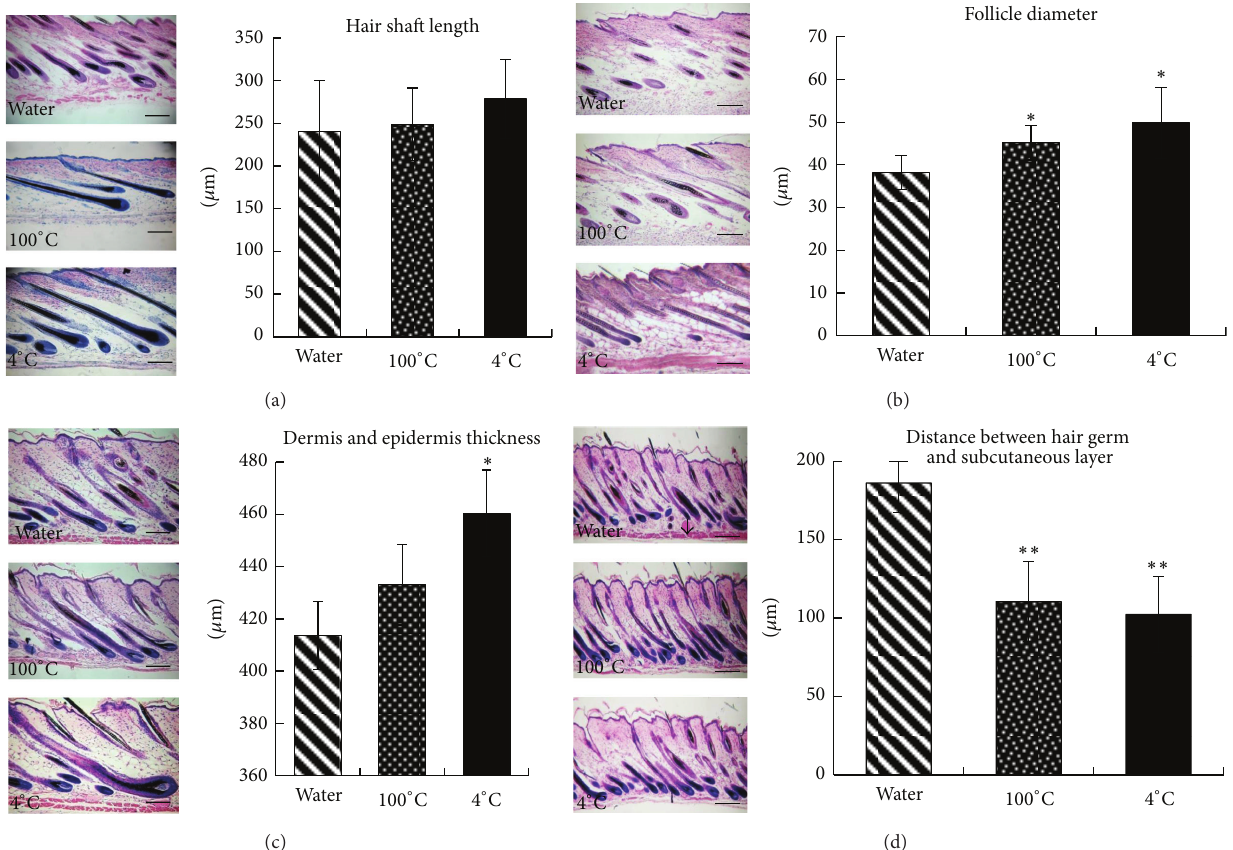
Figure 1: HE staining and quantitative morphologic analysis of hair follicles. HE-stained paraffin sections of dorsal skin of control (water) and 100 ∘ C or 4 ∘ C deer antler extract-treated mice were examined at 100x magnification. (a) Quantitative analysis of the hair shaft length. (b) Hair follicle diameter of the different groups. (c) Thickness of the dermis and epidermis in the different groups. (d) Distance between the hair germ and the subcutaneous layer in the different groups. ((a)–(d) left part) Sections of the back skins were stained, and representative photomicrographs of skin sections are shown. Bars are 100 𝜇 m. Values are mean ± standard deviation (SD) ( 𝑛 = 10 /mouse; ∗ 𝑃 < 0.05 and ∗∗ 𝑃 < 0.01 compared to control). Nine sections were reduplicated in each